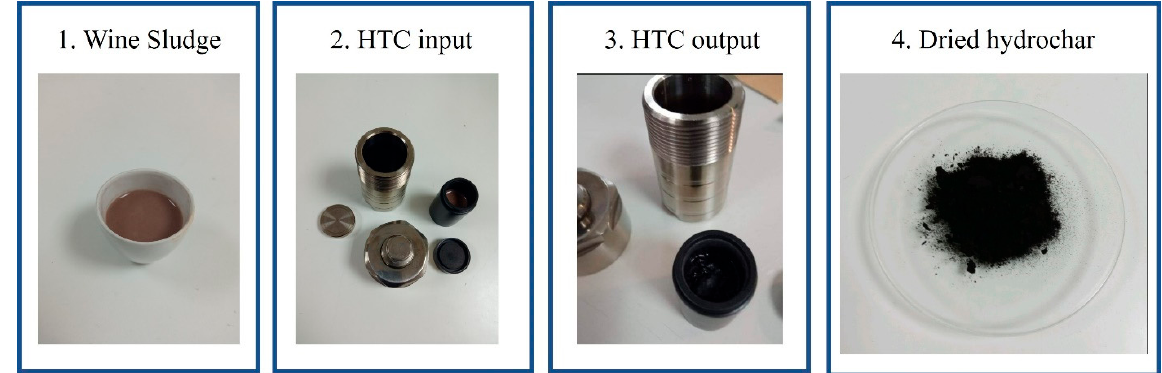
Figure 2. Input raw wine sludge and produced hydrochar. balances are shown in Equations (1)–(4).